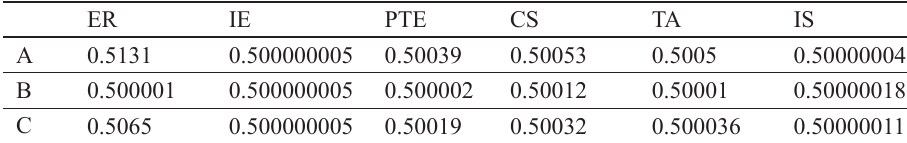
Table 6. Grey incidence matrixes